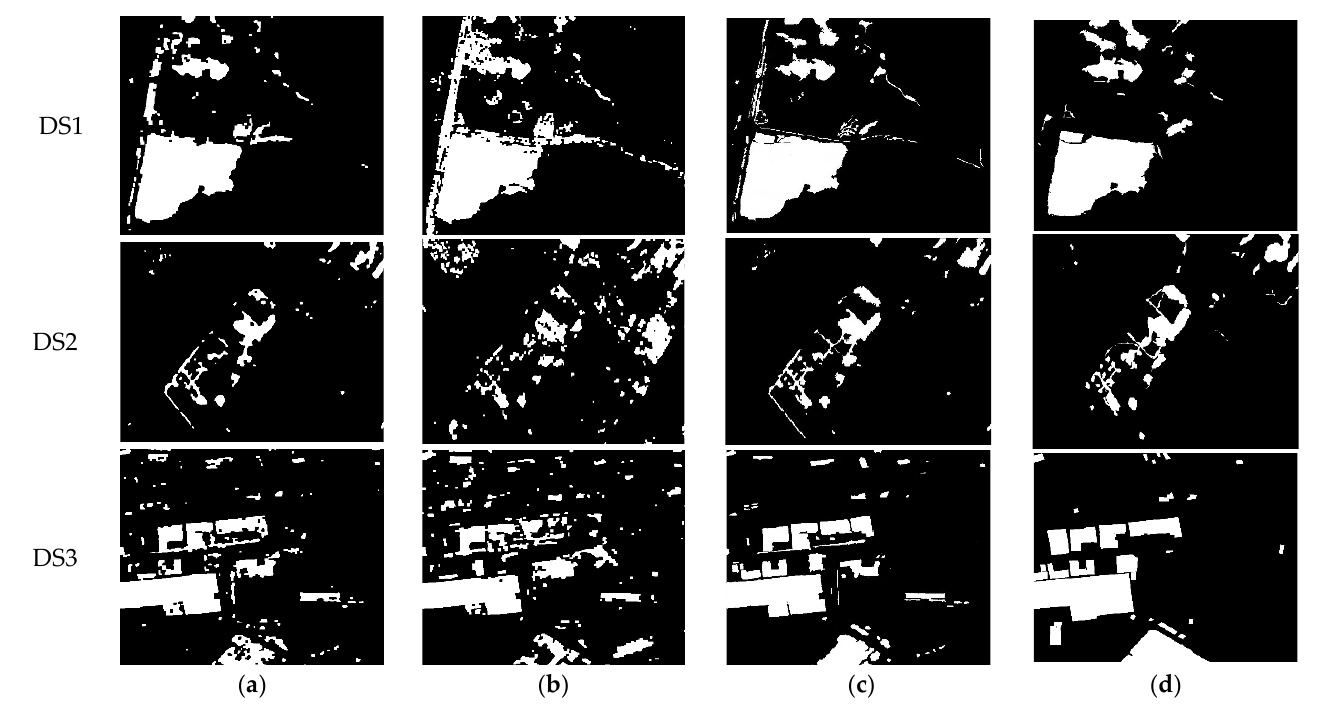
Figure 8. Comparison of post-processing methods: ( a ) multi-feature + morphology operation; ( b ) spectra + morphology operation; ( c ) proposed method; and ( d ) reference change map.